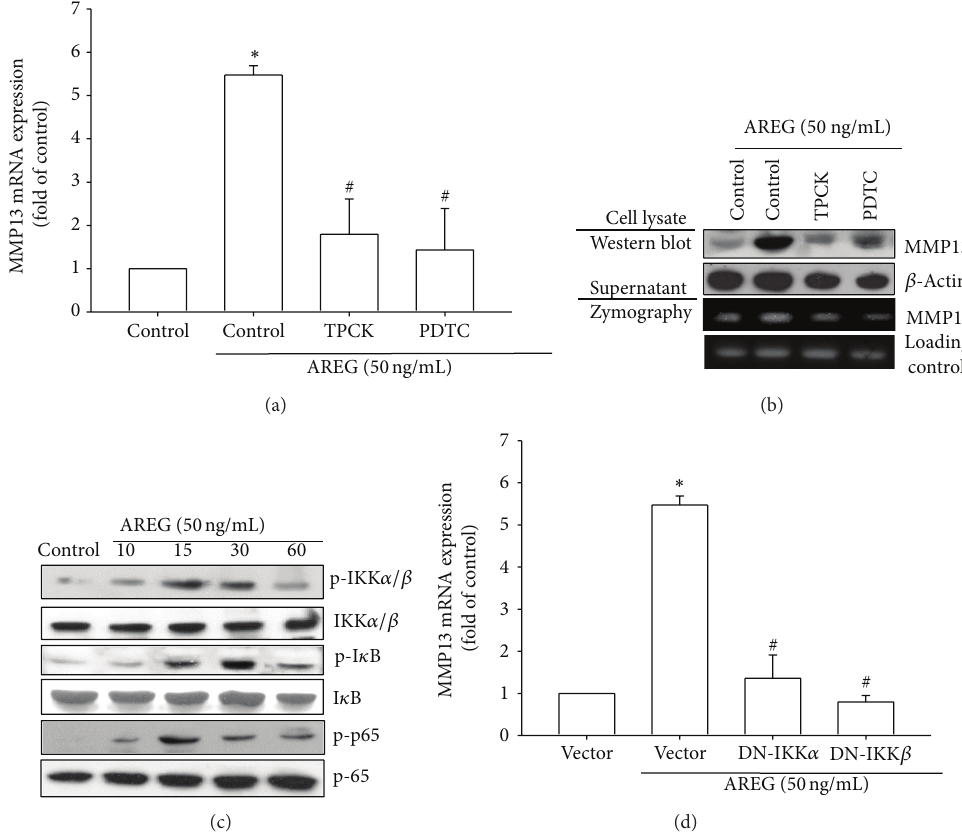
Figure 4: NF- 𝜅 B is involved in the potentiation of MMP-13 production by AREG. (a) OASFs were pretreated for 30min with PDTC (5 𝜇 M) and TPCK (5 𝜇 M) followed by stimulation with AREG for 24h, and MMP-13 expression was examined by qPCR. (b) OASFs were pretreated for 30 min with PDTC (5 𝜇 M) and TPCK (5 𝜇 M) for 30min followed by stimulation with AREG for 24 h; MMP-13 protein levels in cell lysates were determined by Western blot analysis. MMP-13 enzymatic activity in cell lysates and supernatants was measured using zymography. (c) OASFs were incubated with AREG for indicated time intervals; p-IKK 𝛼 / 𝛽 , p-I 𝜅 B 𝛼 , and p-p65 expression was determined by Western blot analysis. (d) OASFs were transfected for 24 h with IKK 𝛼 and IKK 𝛽 mutant followed by stimulation with AREG for 24 h; and MMP-13 expression was examined by qPCR. Results are expressed as the mean ± SEM (𝑛 = 3) . ∗ 𝑃 < 0.05 compared with control; # 𝑃 < 0.05 compared with AREG-treated